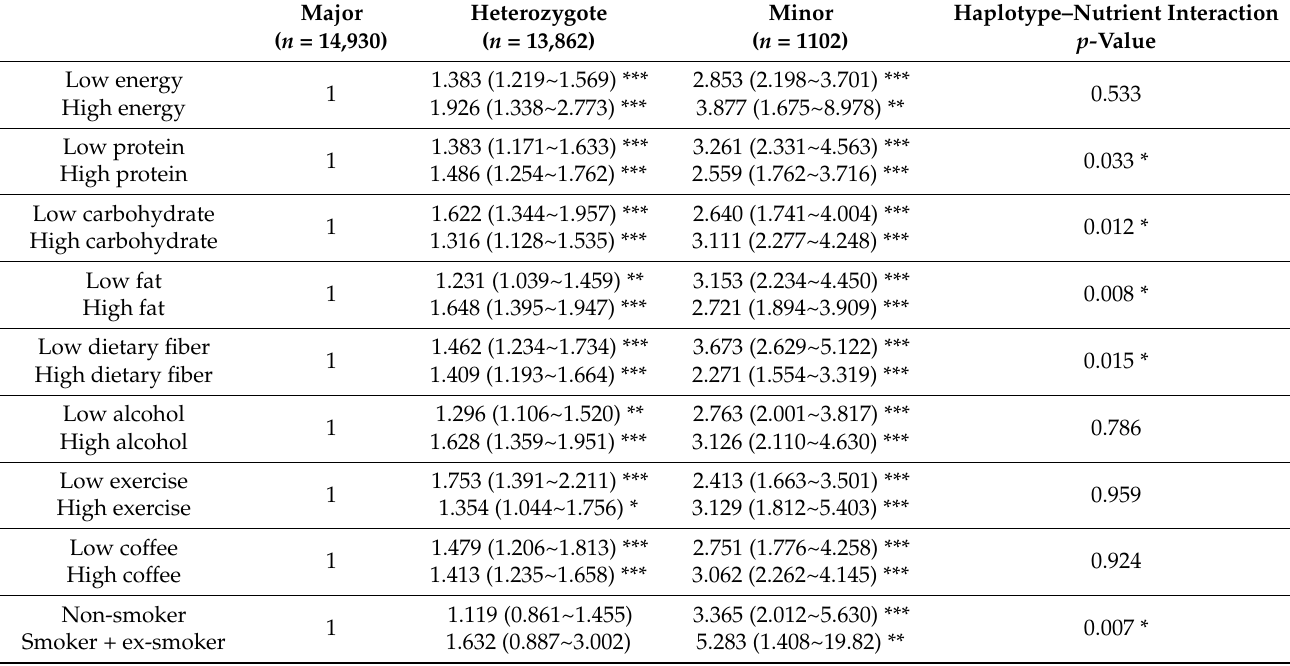
Table 5. Adjusted 3GO for the risk of 3GO and related parameters according to the haplotype of KCNQ1_rs2237892